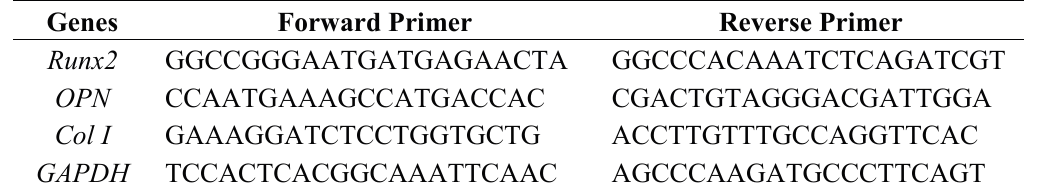
Table 1. Sequences of the primers used in the real-time polymerase chain reaction